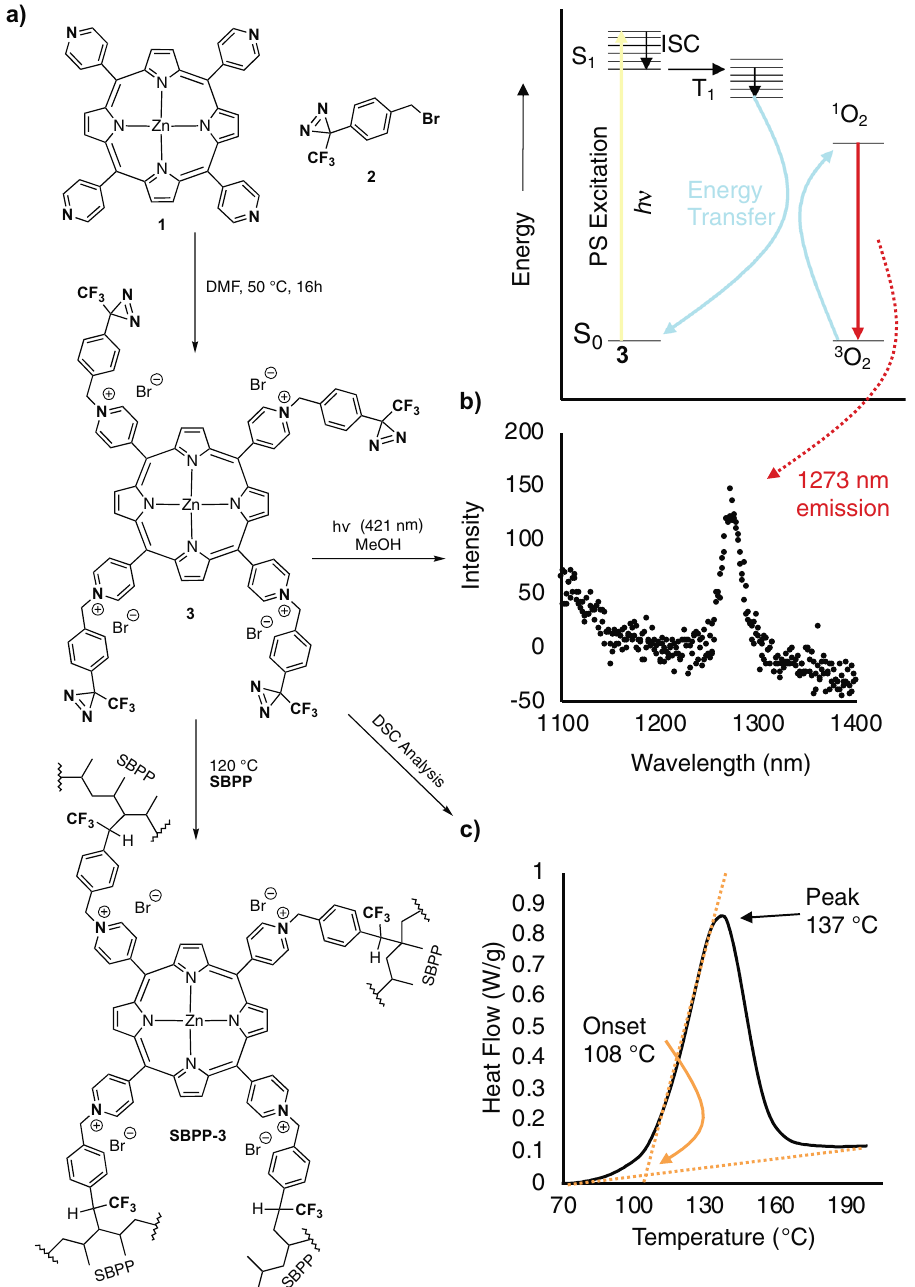
Figure 2. ( a ) Synthesis of 3 and subsequent SBPP functionalization. ( b ) 1 O 2 phosphorescence after excitation of 3 at 421 nm. ( c ) DSC of 3 indicating the onset and peak reaction temperature of the